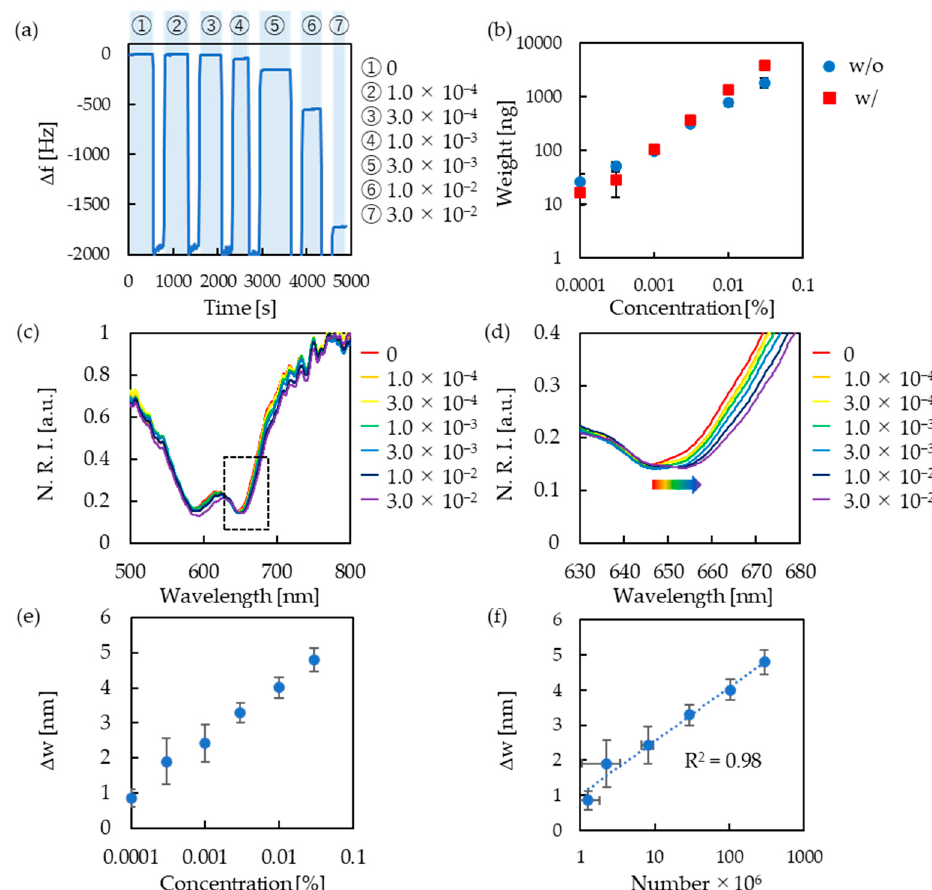
Figure 4. ( a ) Resonance frequency change measured by a QCM devices with nanostructure when nanoparticles (1.0 × 10 − 4 –3.0 × 10 − 2 % ( w / w )) are adsorbed. The vertical axis shows ∆ frequency ( ∆ f). ( b ) Comparison of weight response to nanoparticle concentrations with and without a nanos- tructure on a QCM device. ( c ) Reflection spectra of gold nanostructure in various concentrations of nanoparticle dispersion (1.0 × 10 − 4 –3.0 × 10 − 2 % ( w / w )). ( d ) Enlarged figure of absorption peak in ( c ) (dotted square part). ( e ) Peak wavelength shift with different concentrations of nanoparticle dispersion. The vertical axis shows ∆ wavelength ( ∆ w). ( f ) Peak wavelength shift with number of adsorbed